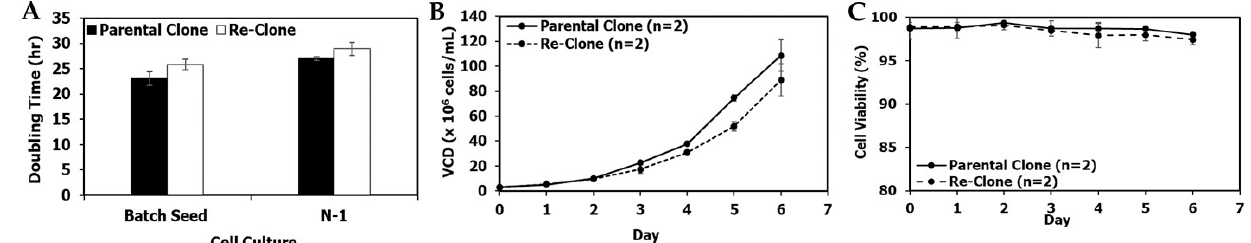
Figure 9. mAb3 seed and N-1 culture performance of the parental and re-clone. ( A ) Doubling times for the shake flask batch seed cultures and the N-1 5-L cultures, ( B ) N-1 fed-batch 5-L bioreactor viable cell density (VCD), ( C ) N-1 viability. The values are reported as average ± difference/2 (n = 2).